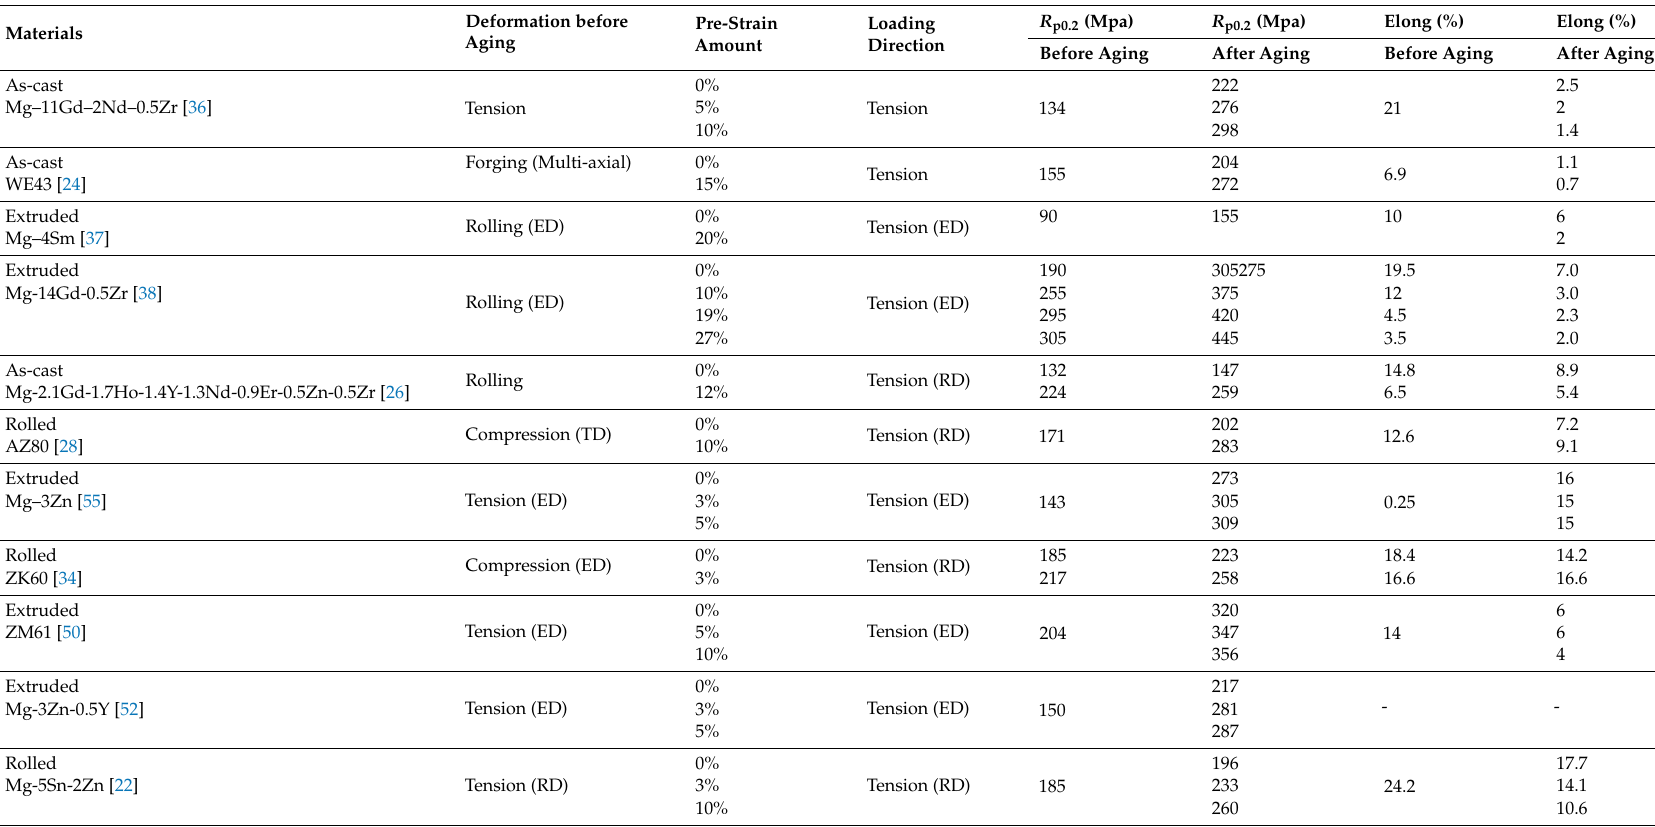
Mechanical properties of various Mg alloys subjected to di ff erent treatments. The sample sizes for mechanical testing can be found in the corresponding